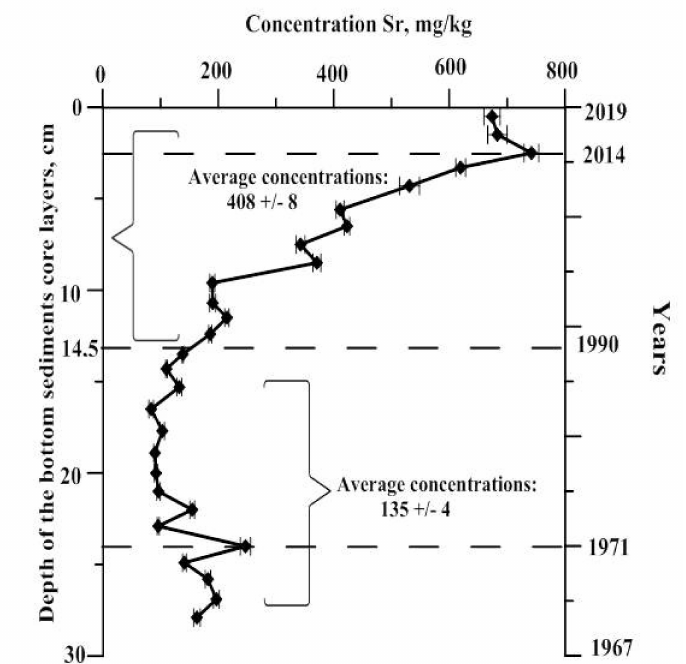
Figure 4. Distribution of Sr (stable isotope) in the core of bottom sediments of Lake Aktashskoye. The layer-by-layer distribution of Ba in the core of the bottom sediments of Lake Aktashskoye varied in the range of 47.7–89.3 mg kg − 1 of dry weight, and practically did not differ both in the period before and after 1990 (Figure 5).